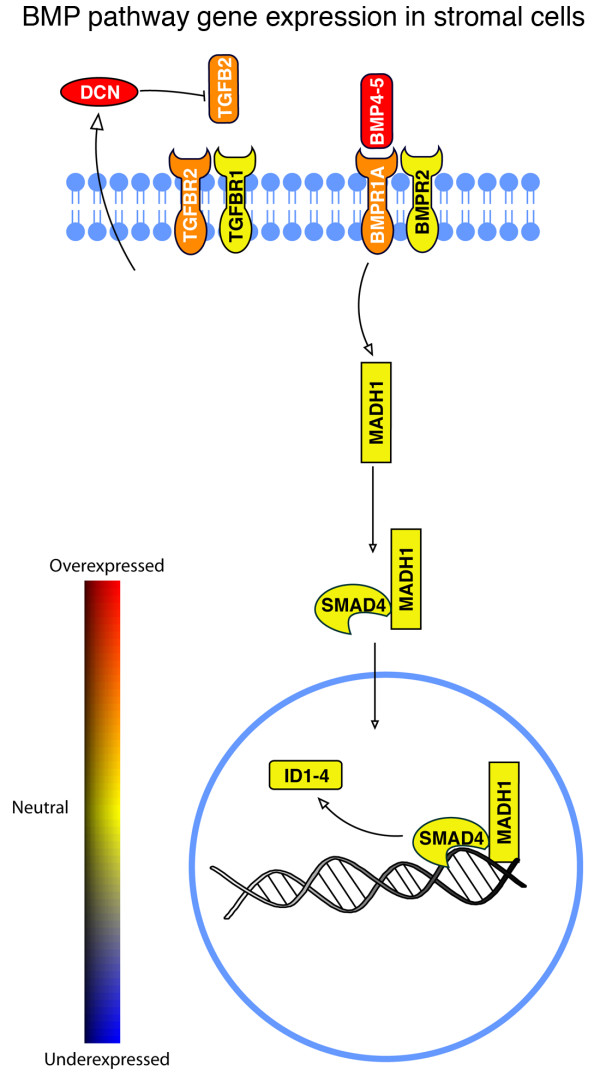
Transcript expression of BMP signaling pathway members. The diagram indicates cellular locations of differentially expressed genes in the BMP signaling pathway in prostate stromal cells. Decorin, a negative regulator of TGFβ signaling, is produced by stromal cells, which may result in autocrine regulation of the pathway. BMP4 and BMP5 are produced by stromal cells and may be responsible for paracrine regulation of Inhibitor of Differentiation (ID) gene expression in the prostate.